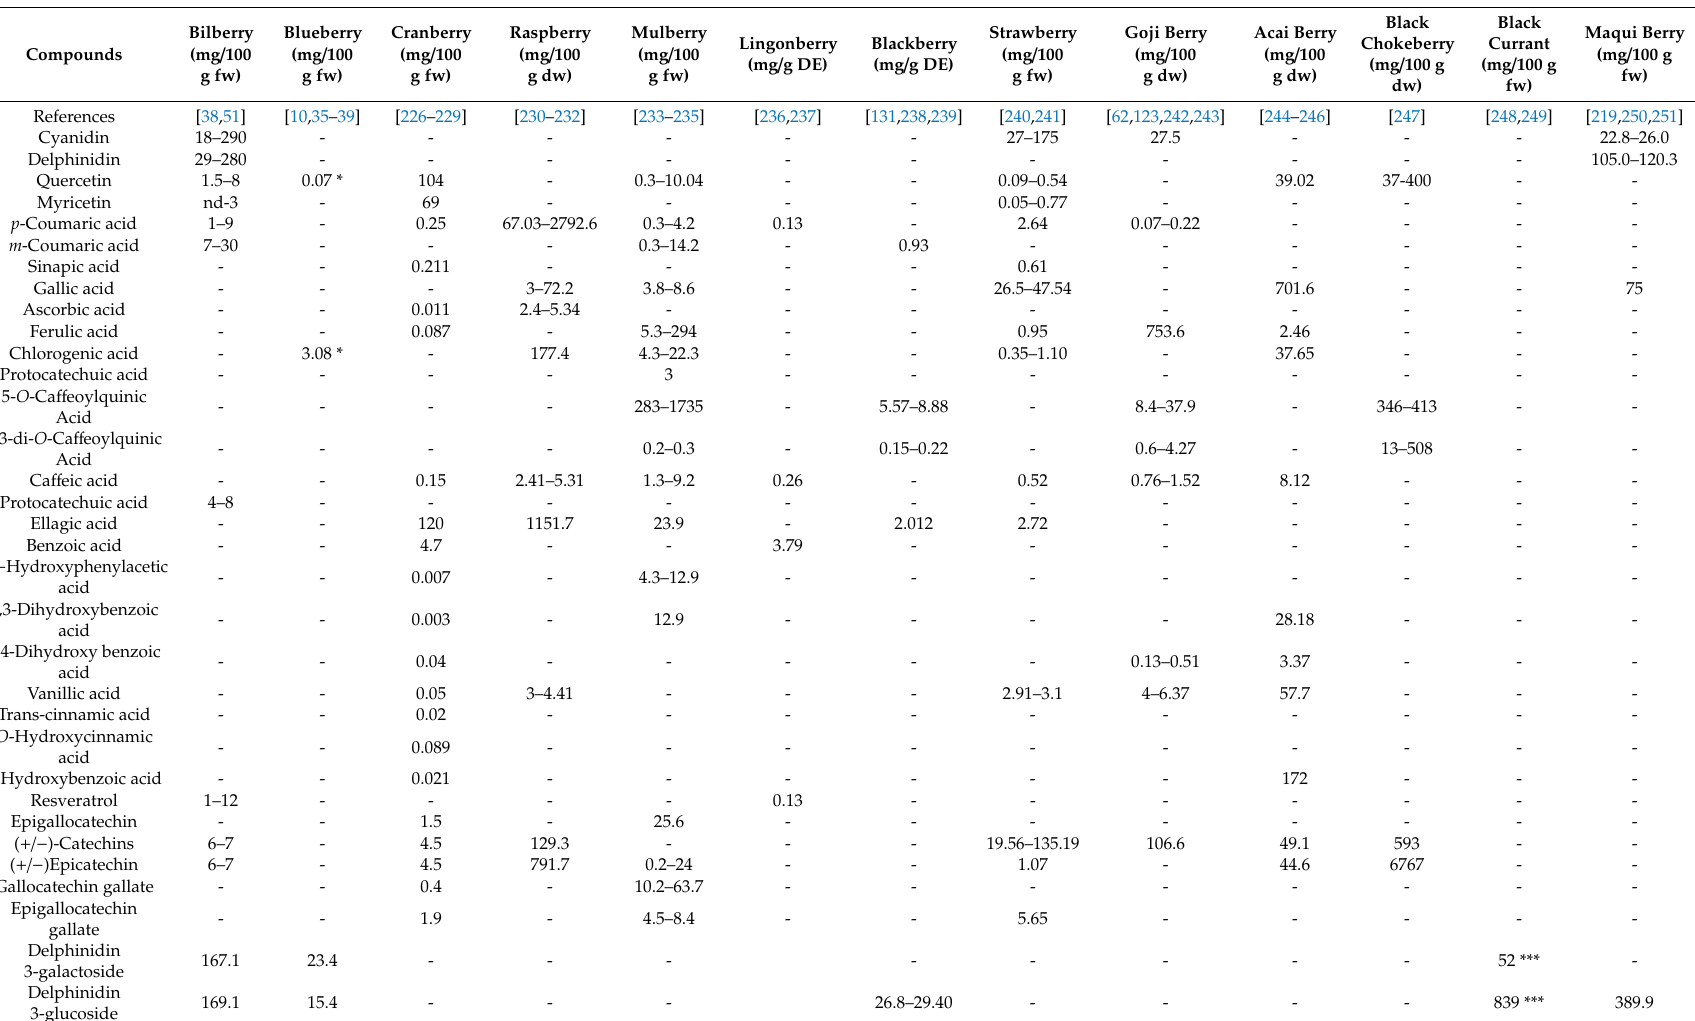
Table 2. A comprehensive list of potential health promoting individual anthocyanins and phenolic compounds with their quantities found in berries or berry products.